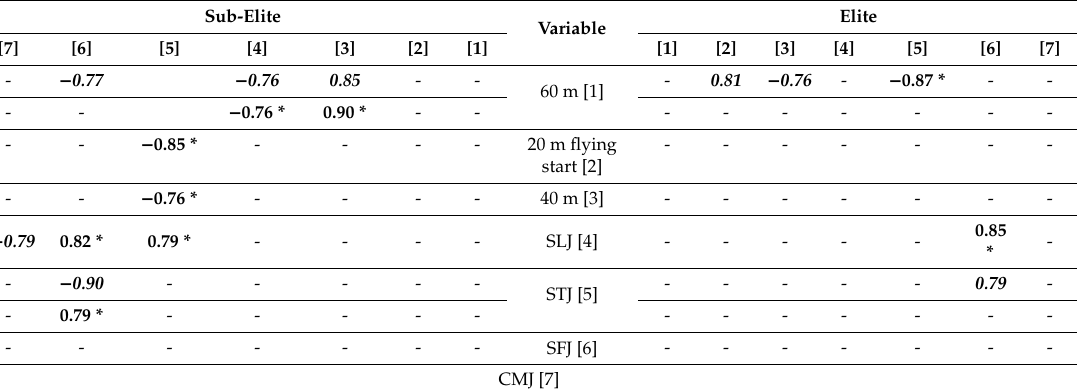
Table 6. Spearman rank correlation coe ffi cients between sprint performance and lower extremity explosive power variables.